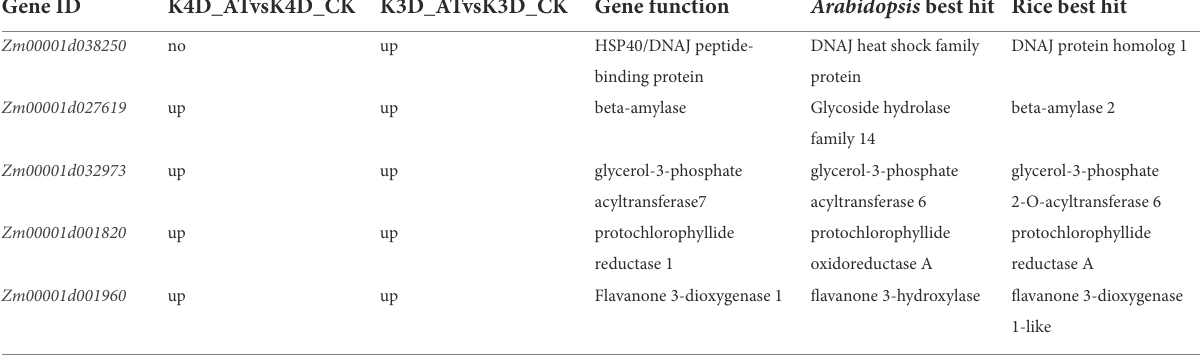
TABLE 4 Candidate DEGs that are consistent between the K4D_ATvsK4D_CK and K3D_ATvsK3D_CK comparison groups.